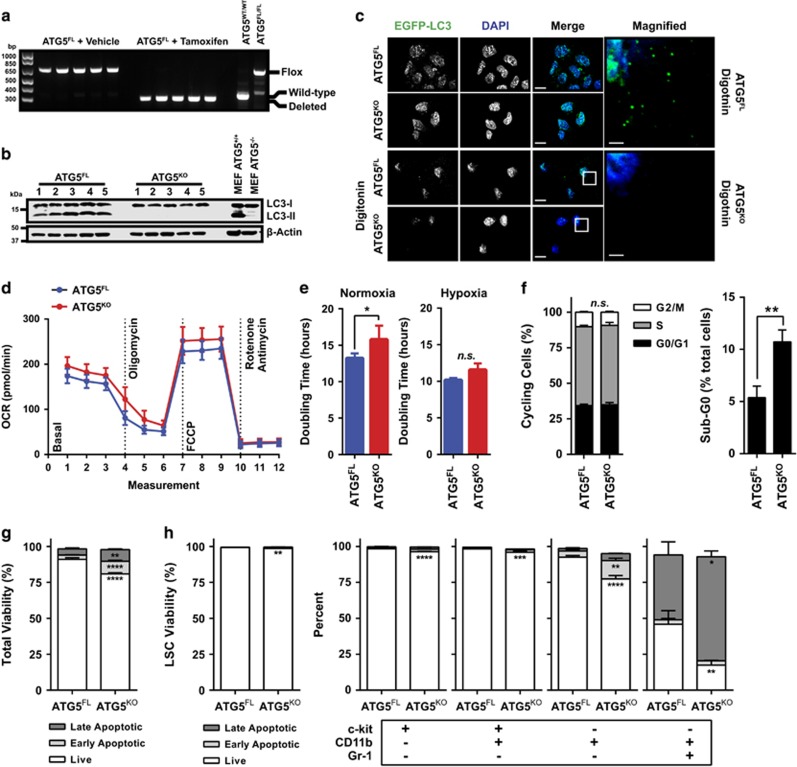
Autophagy, proliferation, and apoptosis of in vitro cultured Atg5FL and Atg5KO cells. (a) Genomic DNA extracted from the splenocytes of five moribund mice in each group from Figure 3b were analyzed by PCR for the status of Atg5 alleles. DNA extracted from ears of mice with the genotype of Atg5WT/WT and Atg5FL/FL was used as controls. (b) Atg5FL and Atg5KO primary splenocytes from panel (a) were cultured in vitro and treated with 100 nM BafA1 for 2 h, followed by immunoblot analysis. (c) Atg5FL and Atg5KO AML cells from panel (b) were respectively pooled. Slides were either immediately fixed or subjected to digitonin treatment followed by fixation. Slides were then analyzed by immunofluorescence microscopy of GFP-LC3 (green) and DAPI (blue) on the Olympus IX81 deconvolution microscope with × 100 oil immersion objective lens and processed on the Intelligent Imaging Solutions SlideBook 5.0 software. Ten fields of view were analyzed for each group and representative images are shown. Scale bars in merge images represent 10 μm. White boxes in merged images are shown magnified to the right. Scale bars in magnified images represent 2 μm. (d) Atg5FL and Atg5KO cells were analyzed for mitochondrial respiration and presented as oxygen consumption rate (OCR). Error bars represent the S.E.M. of five different clones. (e) Five clones each of Atg5FL and Atg5KO cells were seeded at 1 × 104 cells/well in 96-well plates under normoxia and hypoxia, and cell viability was measured every 12 h. Doubling time was calculated according to the exponential growth equation. Statistics were calculated by Student's t-test. *P<0.05 (f) AML cells were subjected to flow cytometric cell cycle analysis and shown as a percentage of all cells excluding Sub-G0 cells on the left. Sub-G0 cells according to cell cycle analysis are shown as a percentage of all cells. (g and h) The viability of AML cells in panel (g), c-kit+Sca-1−CD16/32+CD34− LSCs, and AML cells of the indicated phenotypes in panel (h) were analyzed by flow cytometry and categorized as viable (Annexin V−7-AAD−), early apoptotic (Annexin V+7-AAD−), and late apoptotic (Annexin V+7-AAD+) as a percentage of all cells of the indicated phenotype. Error bars represent the S.D. of five clones in each group. Statistical calculations were performed using ANOVA with multiple comparisons for panels (e–h). *P<0.05; **P<0.01; ***P<0.001; ****P<0.0001